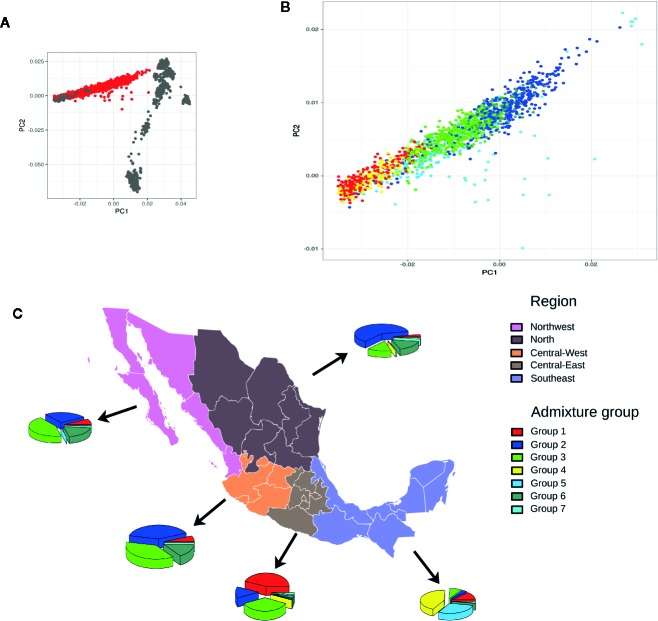
Admixture analysis of the MxGDAR/Encodat. Panels: (A) Principal component analysis with the Human Genome Diversity Project Database (HGDP) admixture reference; individuals from the MxGDAR/Encodat in red and individuals from the HGDP database in gray; (B) Plotting of the individuals from the MxGDAR/Encodat (those in red in panel A), color according to the admixture group identified by Gaussian model-based clustering; (C) Analysis of the geographical distribution of the identified admixture subgroups in each region. Each pie represents the percentages of admixture groups identified in that particular region.